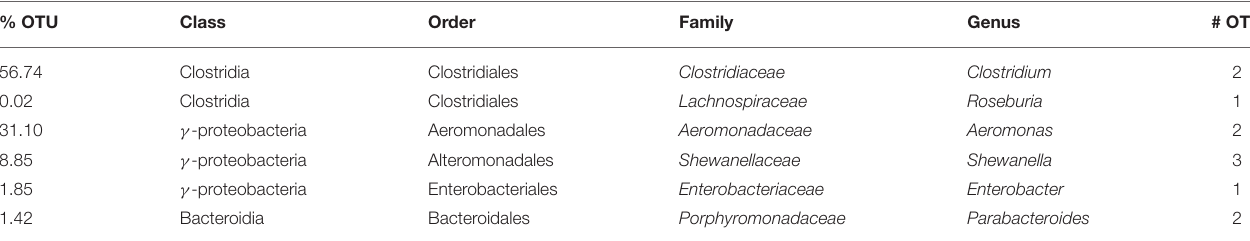
TABLE 1 | Phylogenetic affiliation of the operational taxonomic units (OTU) detected by 16S